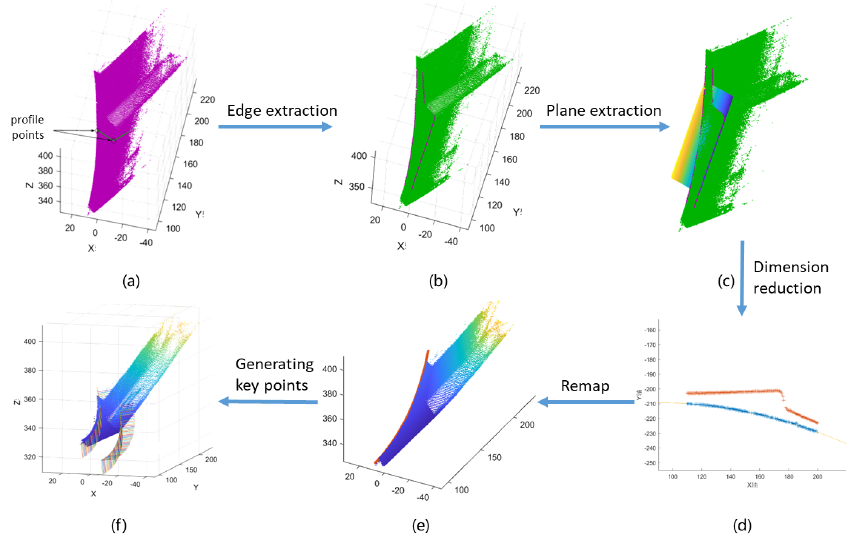
Figure 8. Tool path planning procedure: ( a ) rough point cloud data, ( b ) edge extraction result, ( c ) plane extraction result, ( d ) edge extraction in 2D, ( e ) edge in 2D remapping to 3D, ( f ) key points on